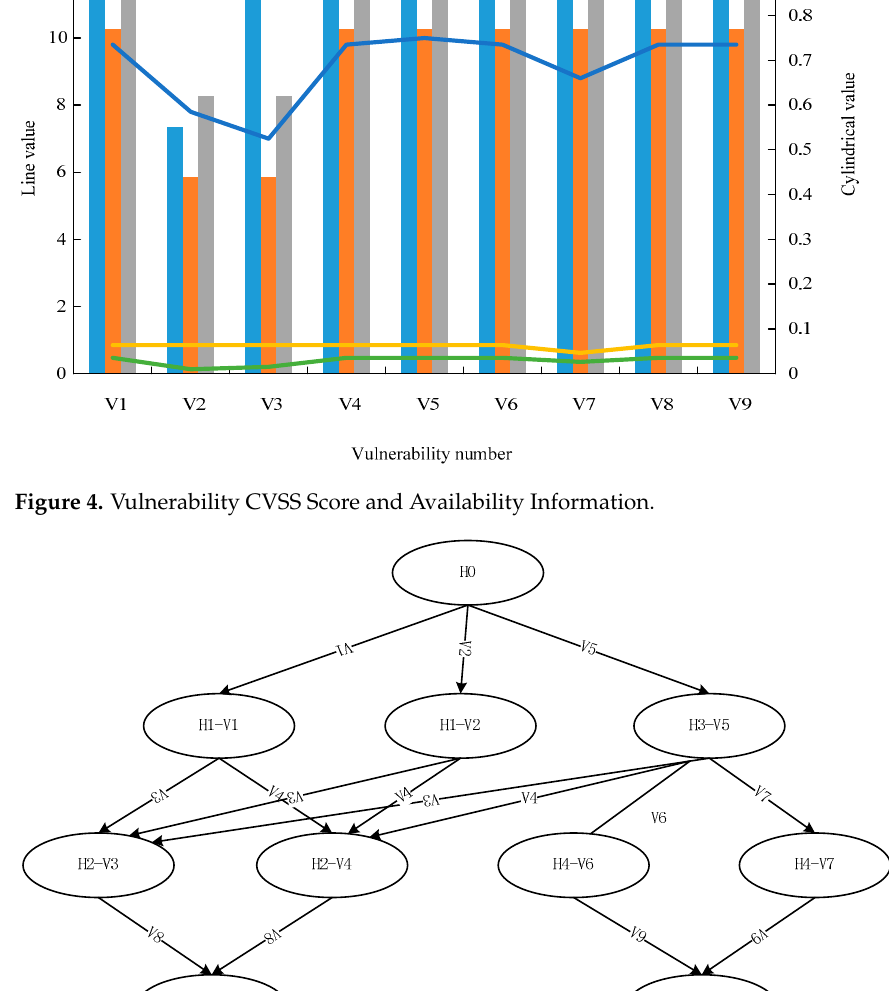
Table 3. Bayesian Attack Graph Node Reachability Probability and Path Reachability Probability.